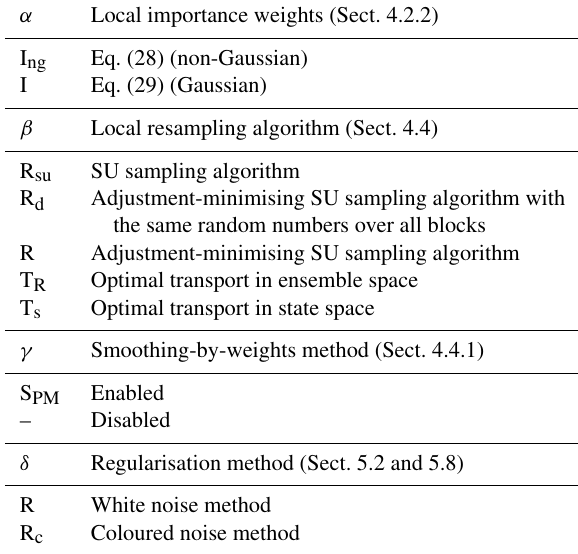
Table 1. Nomenclature conventions for the S( αβ ) x γδ algorithms. Capital letters refer to the main algorithmic ingredients: “I” for im- portance, “R” for resampling or regularisation, “T” for transport, and “S” for smoothing. Subscripts are used to distinguish the meth- ods in two different ways. Lower-case subscripts refer to explicit concepts used in the method: “ng” stands for non-Gaussian, “su” for stochastic universal, “s” for state space, and “c” for colour. Upper- case subscripts refer to the work that inspired the method; “PM” stands for Penny and Miyoshi (2016) and “R” for Reich (2013). For simplicity, some subscripts are omitted: “g” for Gaussian, “amsu” for adjustment-minimising stochastic universal, and “w” for white. Finally, note that we used the subscript “d” (for deterministic) to indicate that the same random numbers are used for the resampling over all